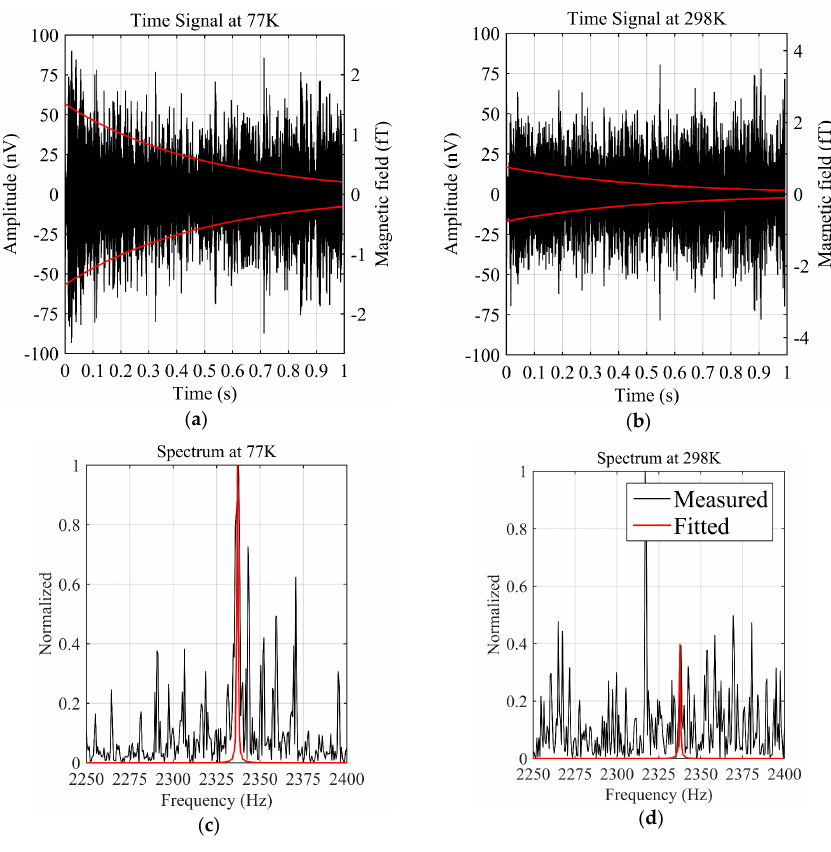
Figure 12. MRS signal and parameter extraction (the signals have two meanings, amplitude (left Y axis) and magnetic field (right Y axis), respectively; black curves are measured data; red curves are the fitted data after data processing.). ( a ) MRS signal at 77 K; ( b ) MRS signal at 298 K; ( c ) Spectrum at 77 K; ( d ) Spectrum at 298 K.